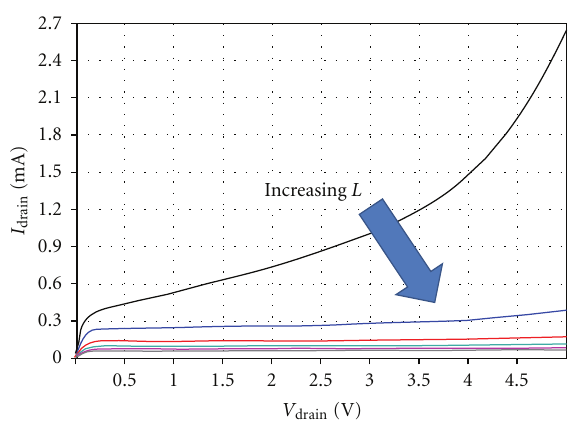
Figure 4: Channel length modulation e ff ects on output resistance as an e ff ect of increasing drain voltage and increasing length. The upper line (black) is a 100 μ m transistor with a 0.5 μ m length, with each line describing a transistor of increasing length by 0.5 μ